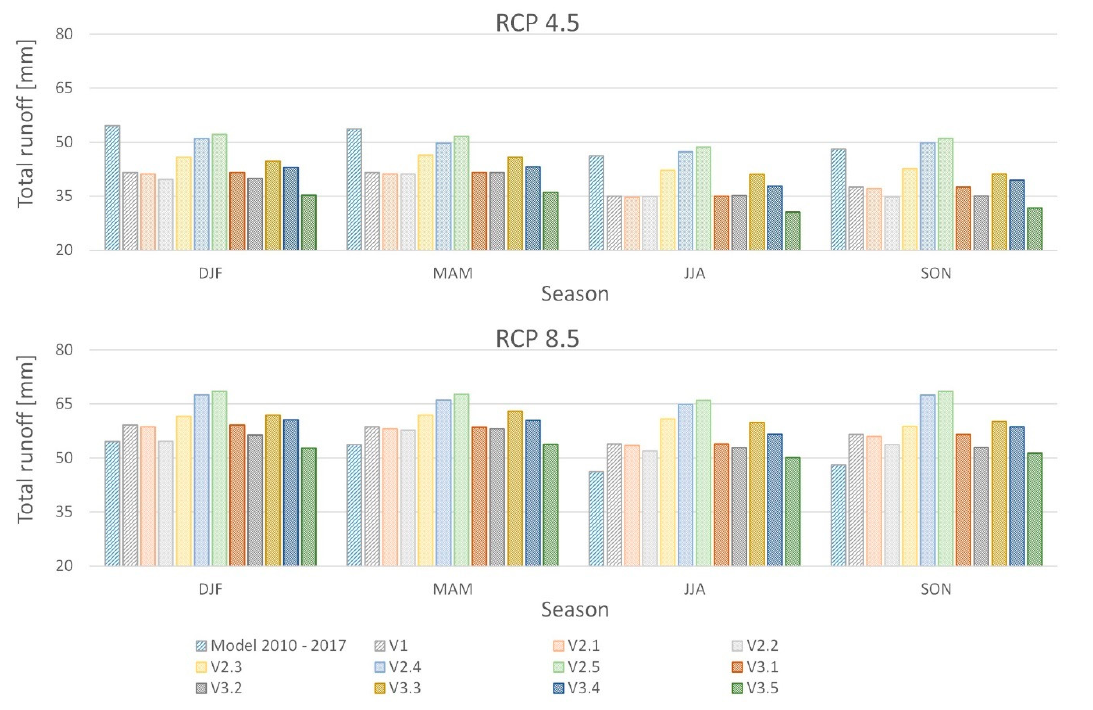
Figure 4. Comparison of the average distribution of total runoff by season for the SWAT 2010–2017 simulation period with variants 1–3 for the RCP 4.5 and RCP 8.5 climate change scenarios, for the years 2041–2050 in the Bystra catchment (author’s own study).